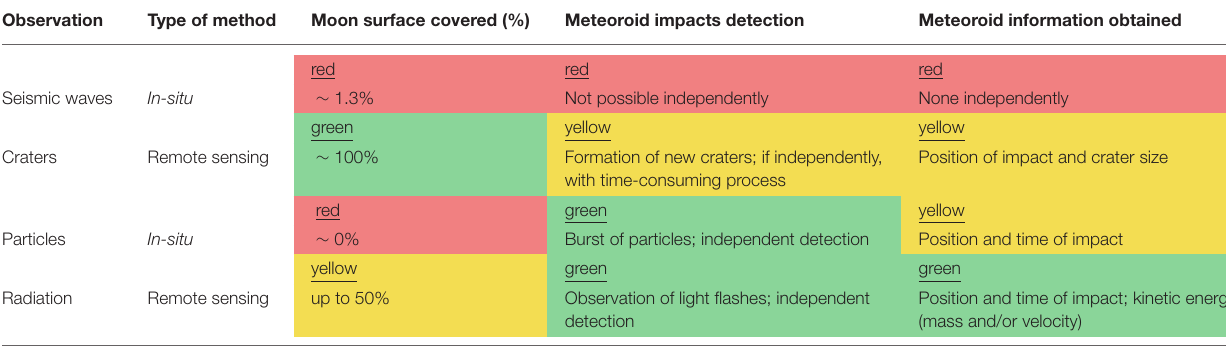
TABLE 1 | Trade-off analysis of methods for the lunar meteoroid impacts observation. Observation